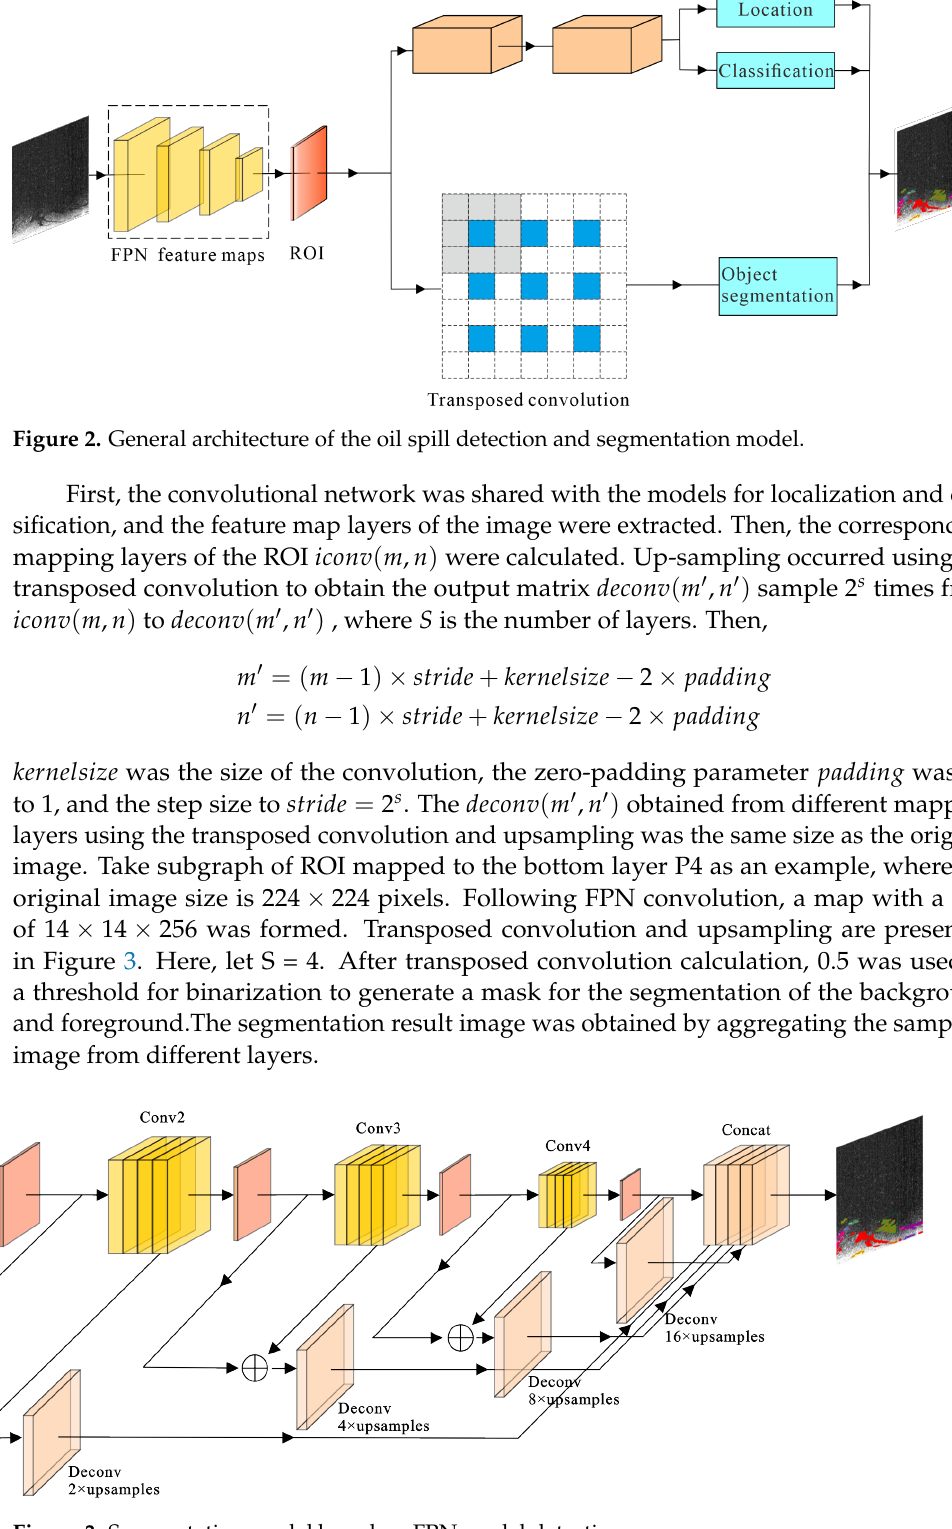
Figure 3. Segmentation model based on FPN model